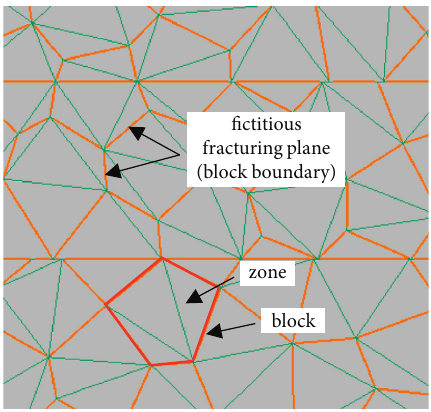
Figure 2: Element of a bonded block